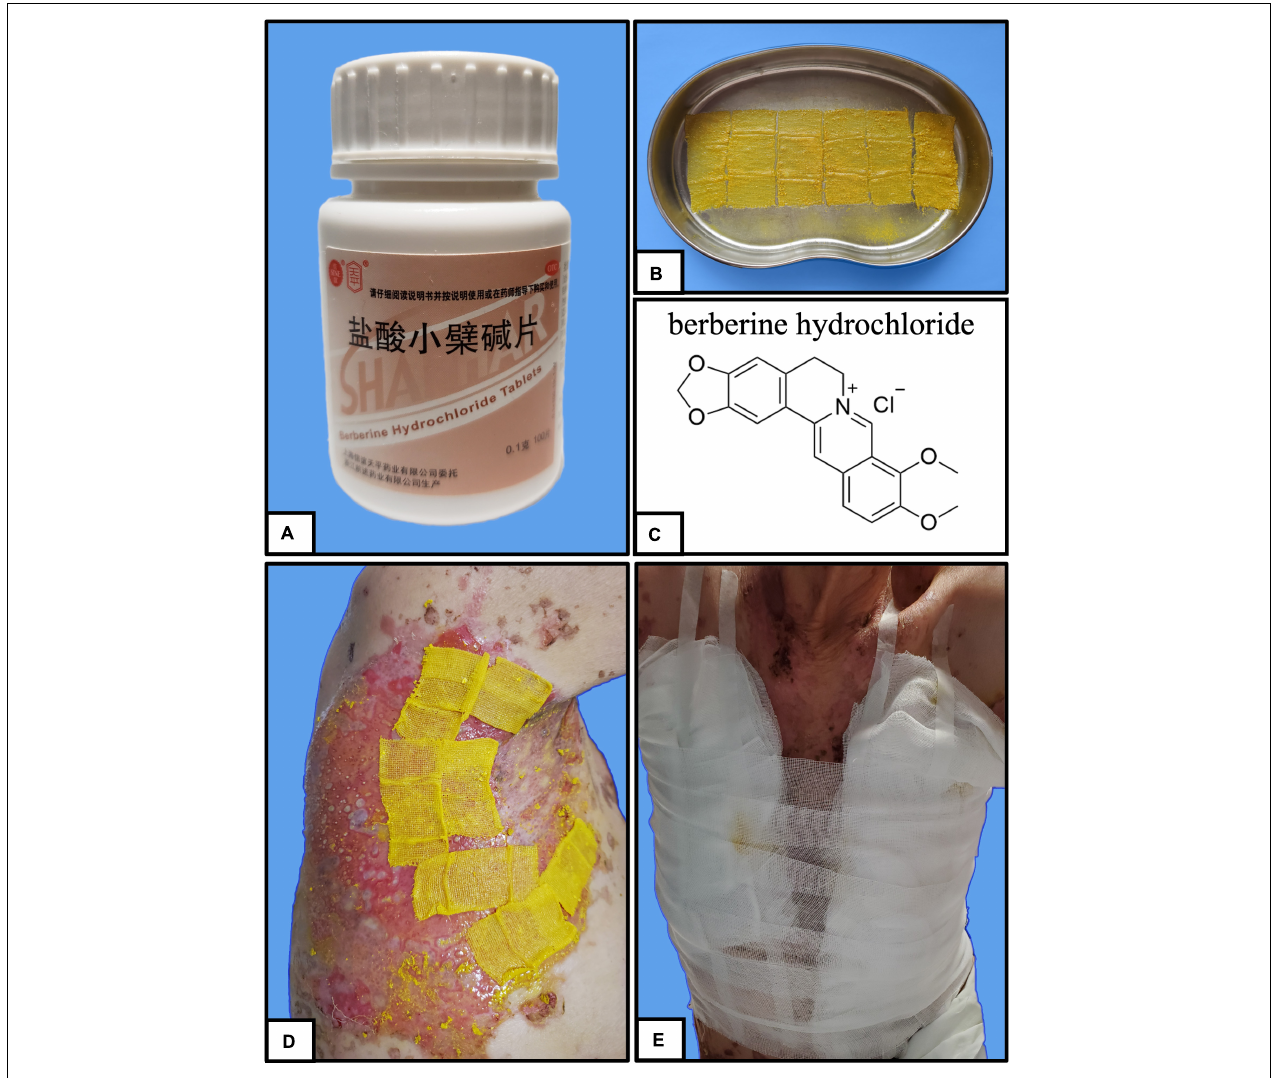
FIGURE 2 | Stamp therapy. (A–C) Stamp gauze soaked with sesame oil mixed with berberine. (D) Stamp gauze is affixed thoroughly to the broken skin of the patient. (E) Bandage is wrapped around the periphery to prevent the gauze from